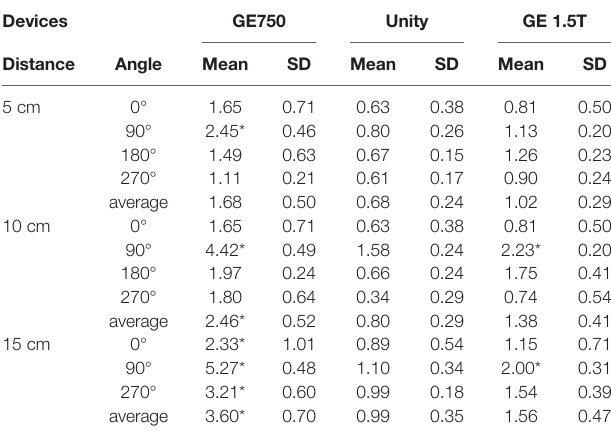
*The symbol in the table represents a distortion larger than 2